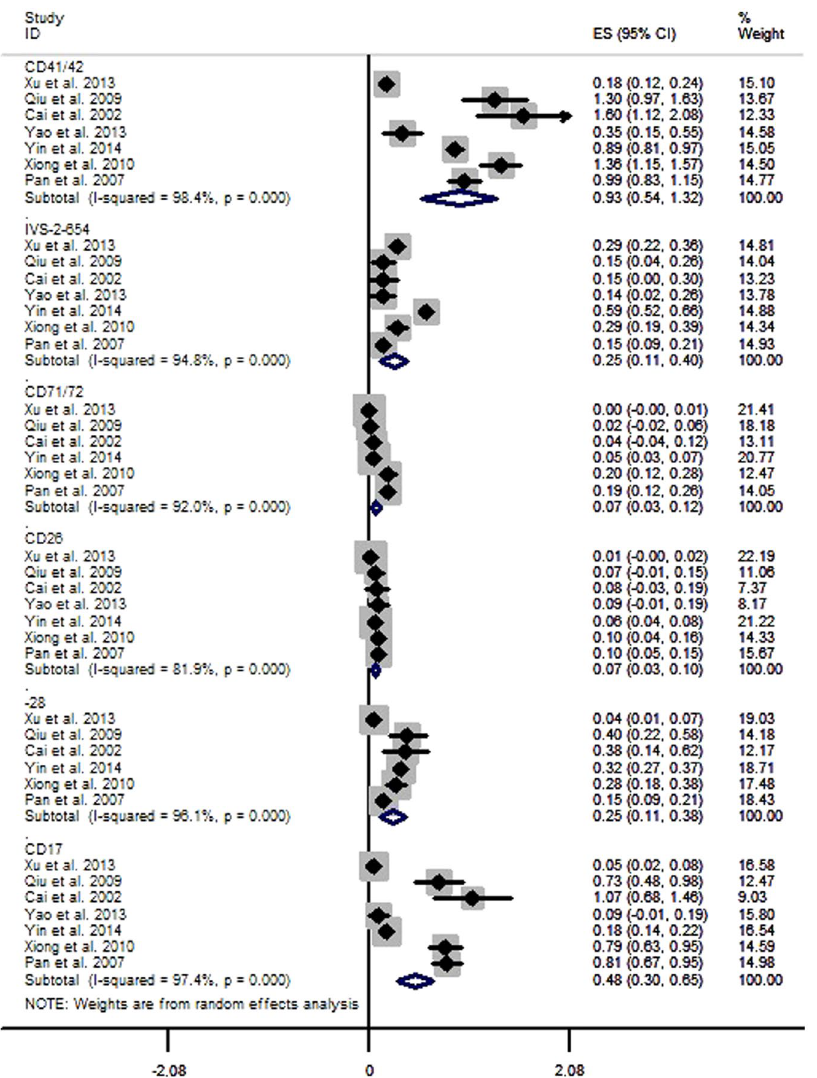
Figure 7. Gene frequencies of β -thalassemia